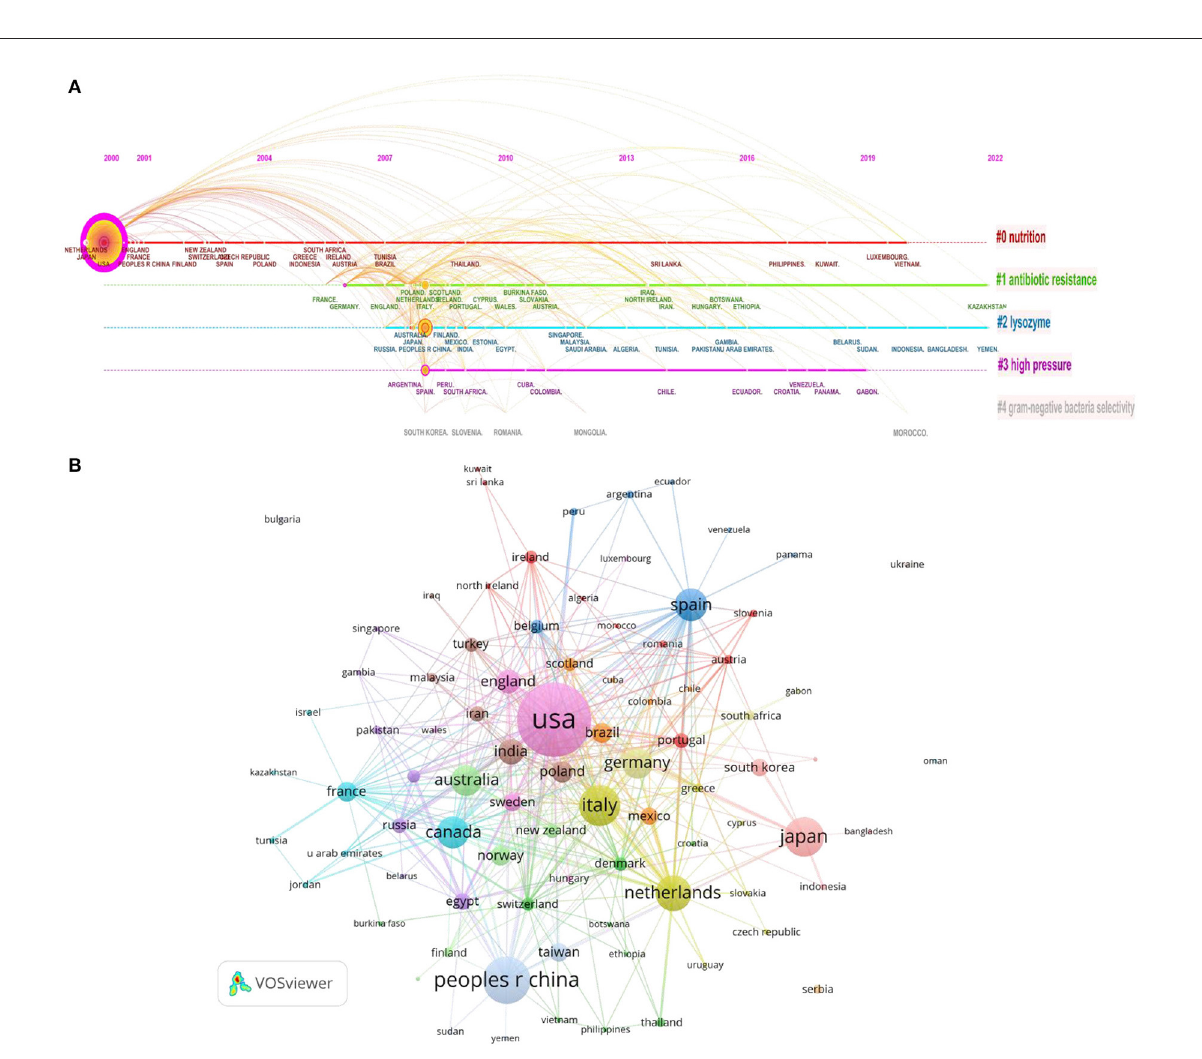
FIGURE2 (A) Timeline view of country coauthorship cluster analysis in the LF antibacterial activity research. (B) Country coauthorship network visualization